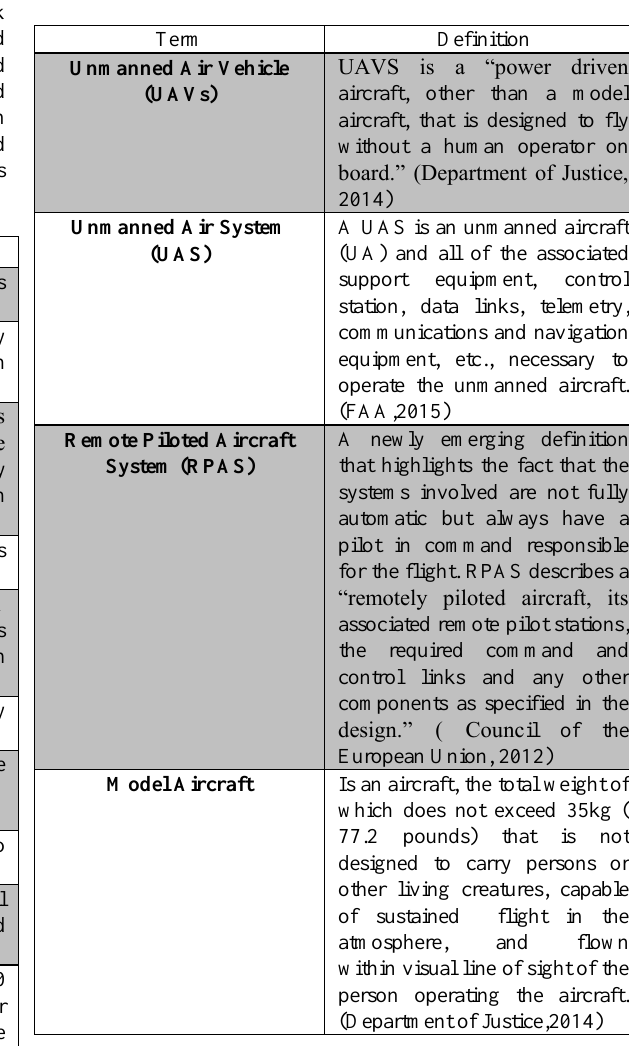
Table 2: The various Terminologies on Drone (Source: Jenkins,